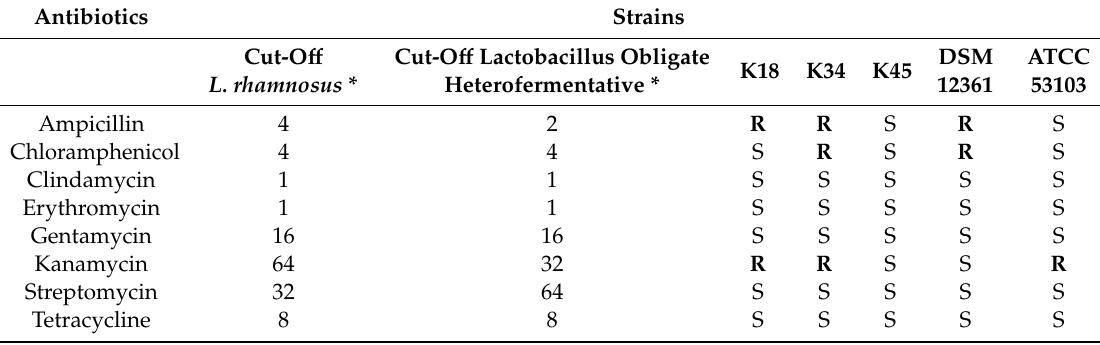
Table 3. Antibiotic susceptibility of A. Kunkeei K18, K34, K45 and DSM 12361 and L. rhamnosus ATCC 53103 as determined with E-test. Cut-o ff values are expressed in µ g / mL. Resistance is reported in bold.